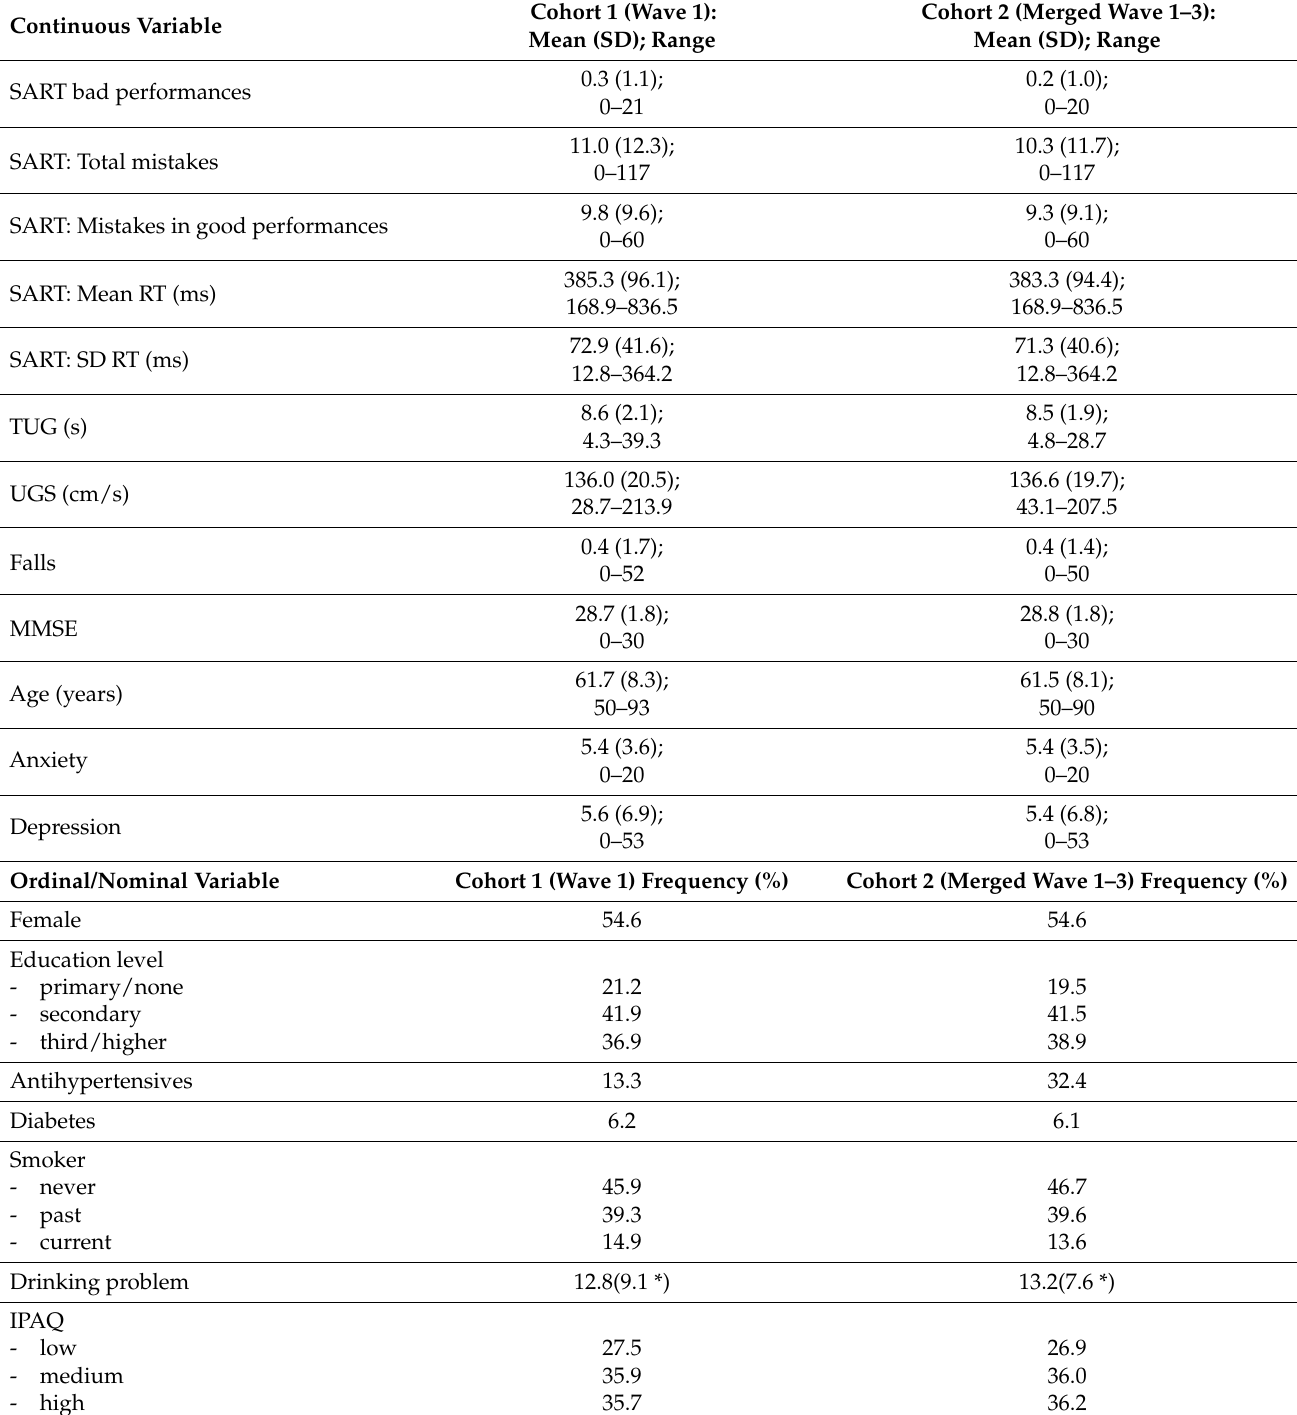
Table 1. Descriptive statistics for the whole set of variables considered in this study at wave 1 for the entire dataset (cohort 1, N = 4864 ) and the merged dataset (cohort 2, N = 3890). The first part of the table gives minimum and maximum values, and mean and SD for each continuous variable. The second part shows ordinal or nominal variables and their frequency in